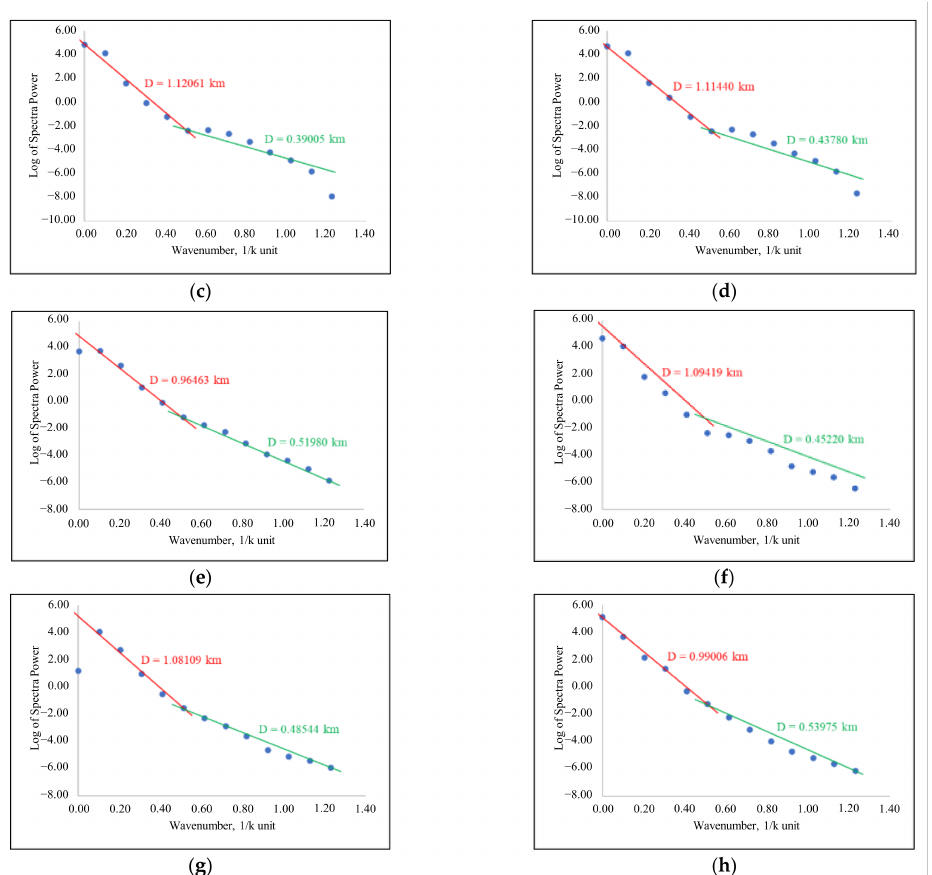
Figure 11. Log of spectra power vs. wavenumber of ( a ) Point 1; ( b ) Point 2; ( c ) Point 3; ( d ) Point 4; ( e ) Point 5; ( f ) Point 6; ( g ) Point 7; ( h ) Point 8.